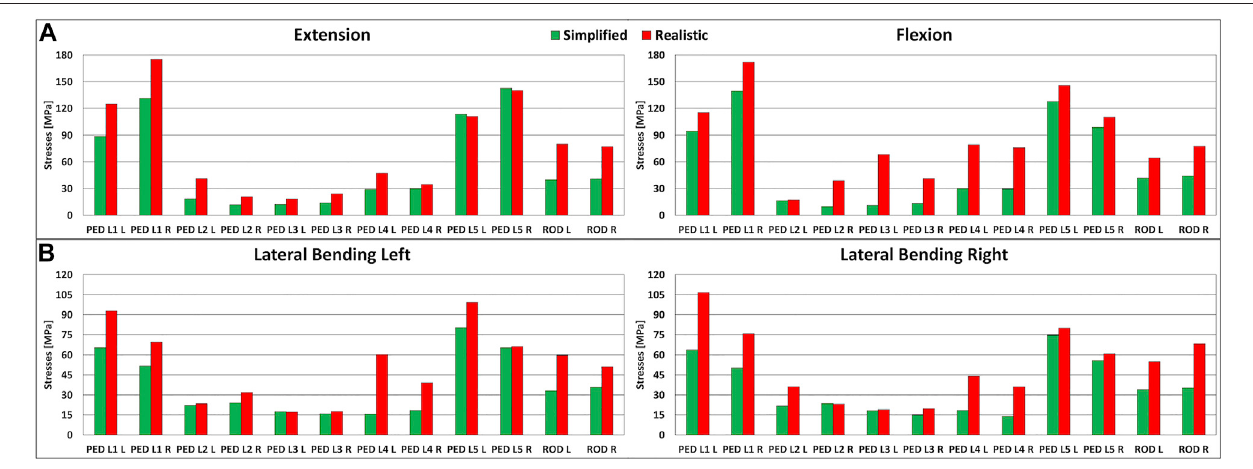
FIGURE 4 | Stresses in the left and right lumbar instrumentation and in the left and right posterior rods. (A) Maximal stresses in the L1-L5 pedicle screws and posterior rodsinextension (left) and in fl exion (right).(B) MaximalstressesintheL1-L5 pedicle screwsand posteriorrodsinlateral bendingonthe leftside (left) and on the right side